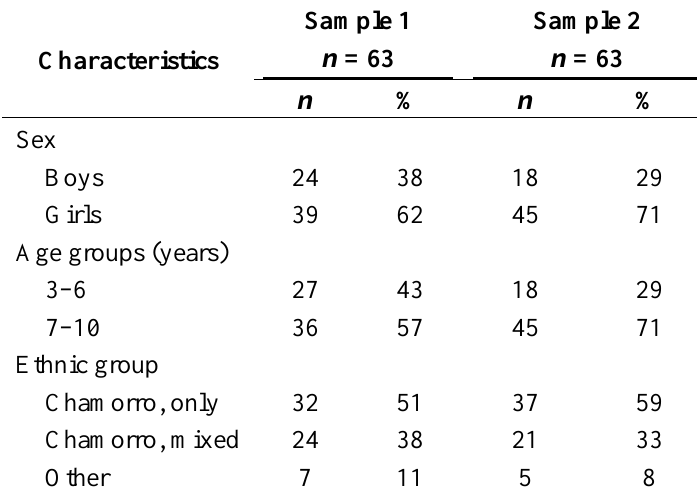
Table 1. Characteristics of children, 3 to 10 years old, attending summer camp in Guam who used the mobile food record and/or provided feedback in 2013 or 2014.